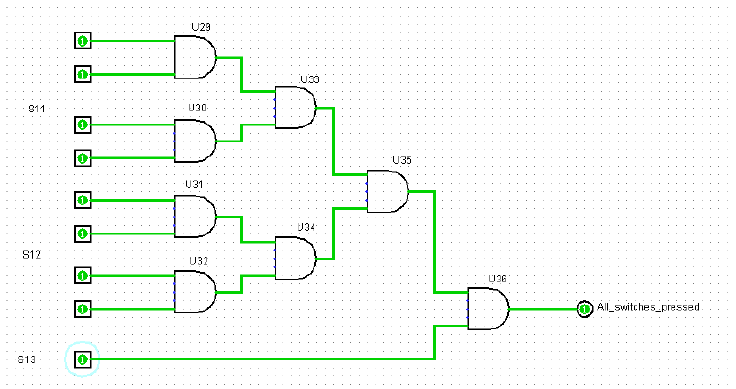
Figure A4. Draw circuit